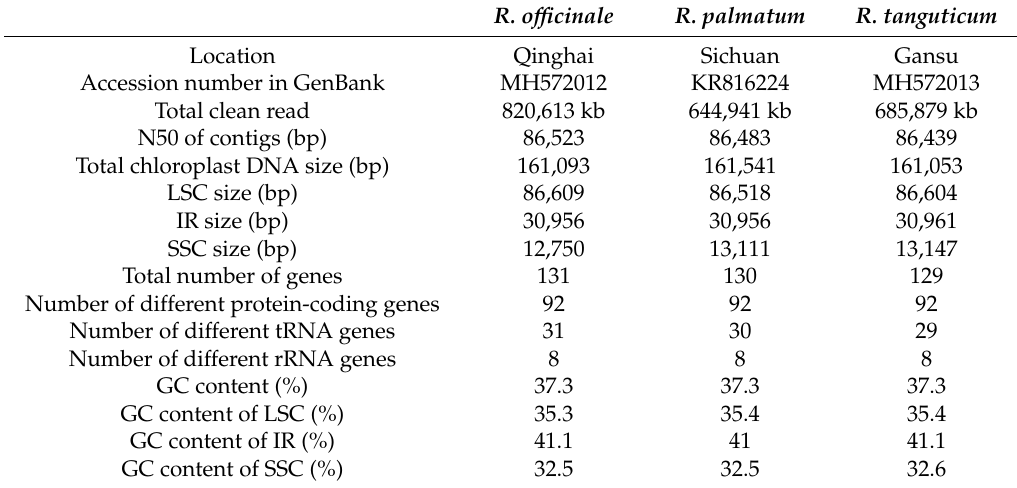
Table 1. The basic characteristics of chloroplast genomes of the three Rheum species.